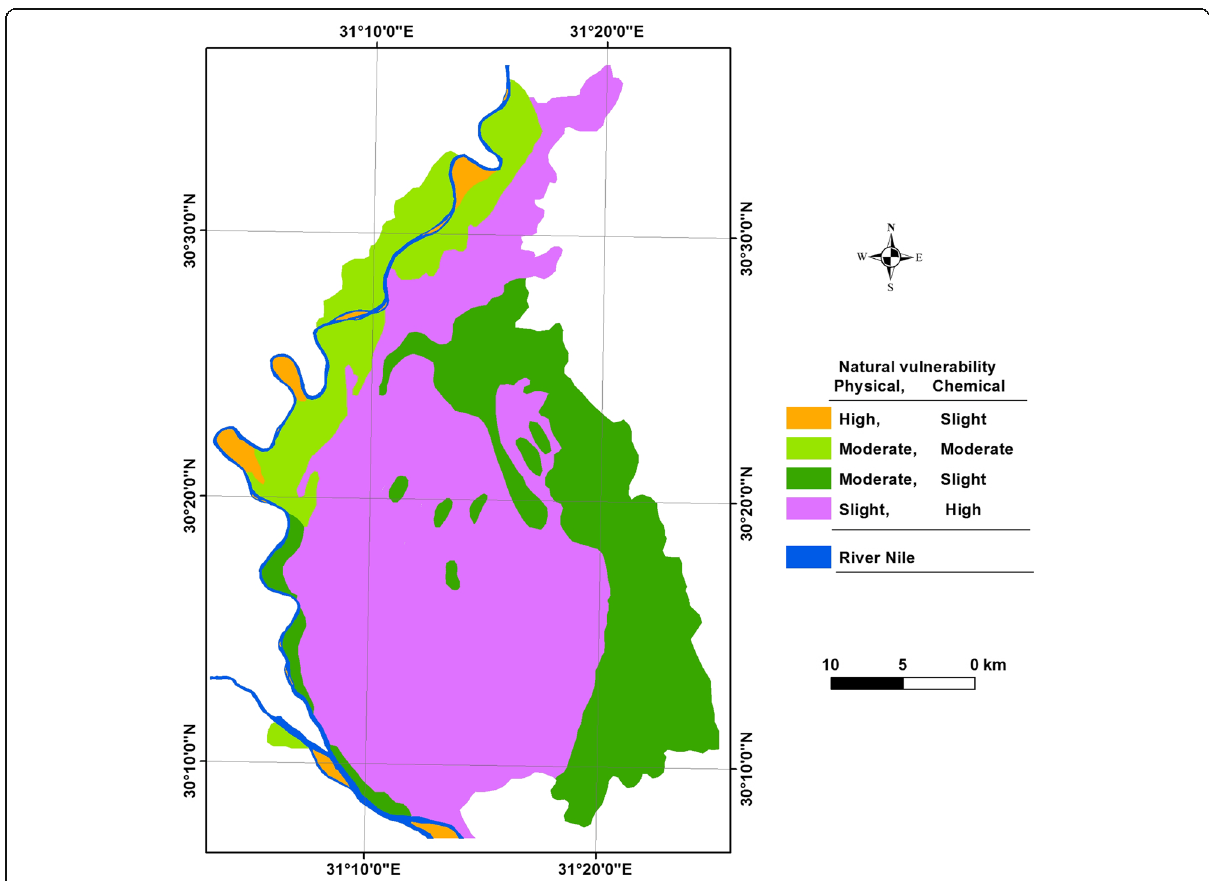
Fig. 4 Natural vulnerability map